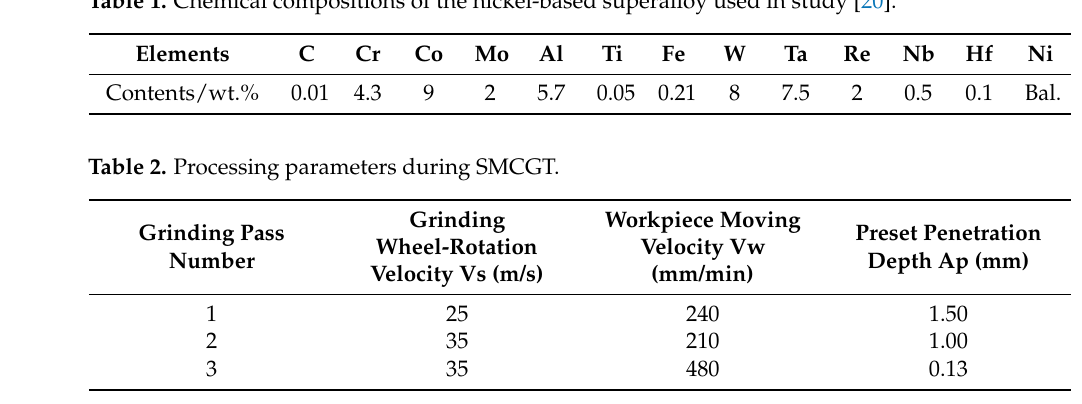
Figure 1. ( a ) The original microstructure of nickel-based superalloy, and schematic illustration of ( b ) the surface mechanical creep-feed grinding process and ( c ) the plastic deformation induced by SMCGT. Table 1. Chemical compositions of the nickel-based superalloy used in study [20].